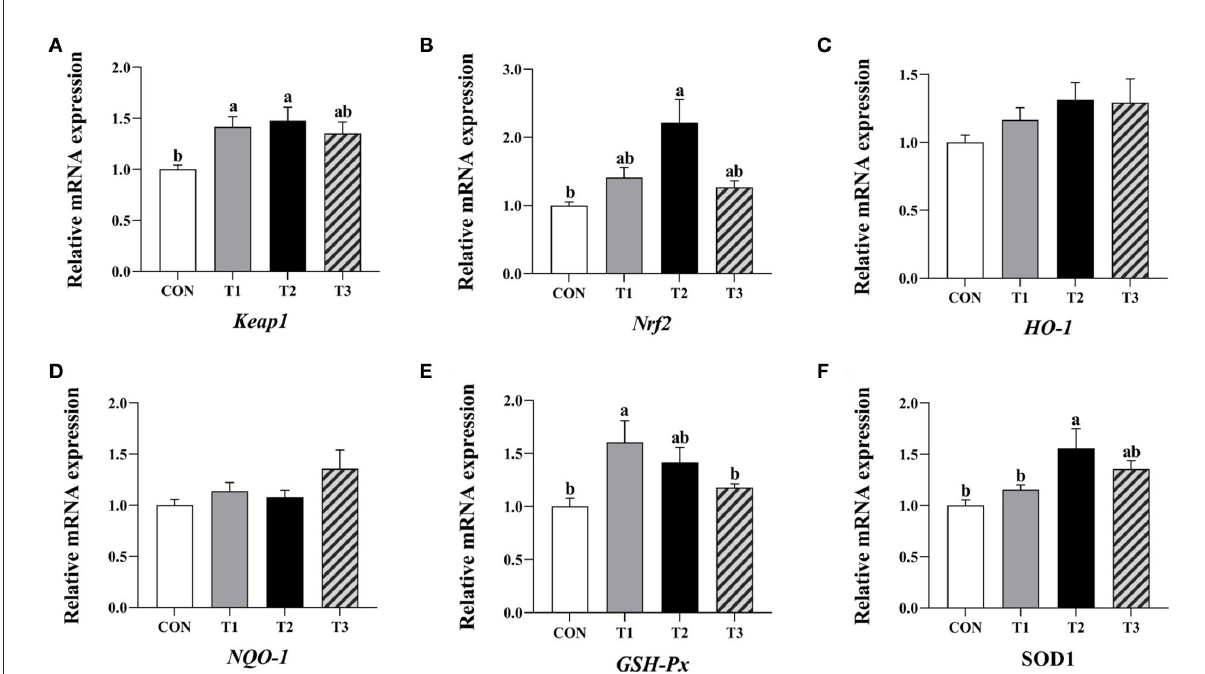
FIGURE1 Effect of quercetagetin on expression level of antioxidant related genes in jejunal mucosa of broilers. Values are means ± standard deviation ( n = 10). Above the bar no letter or the same letter mean no significant ( P > 0.05), while with different letter mean significant difference ( P < 0.05). Kelch-like ECH-associated protein 1 (Keap1) (A) , Nuclear factor E2 related factor 2 (Nrf2) (B) , Heme oxygenase-1 (HO-1) (C) , NAD(P)H: quinone oxidoreductase 1 (NQO-1) (D) , Glutathione peroxidase (GSH-Px) (E) , Superoxide dismutase 1 (SOD1) (F)